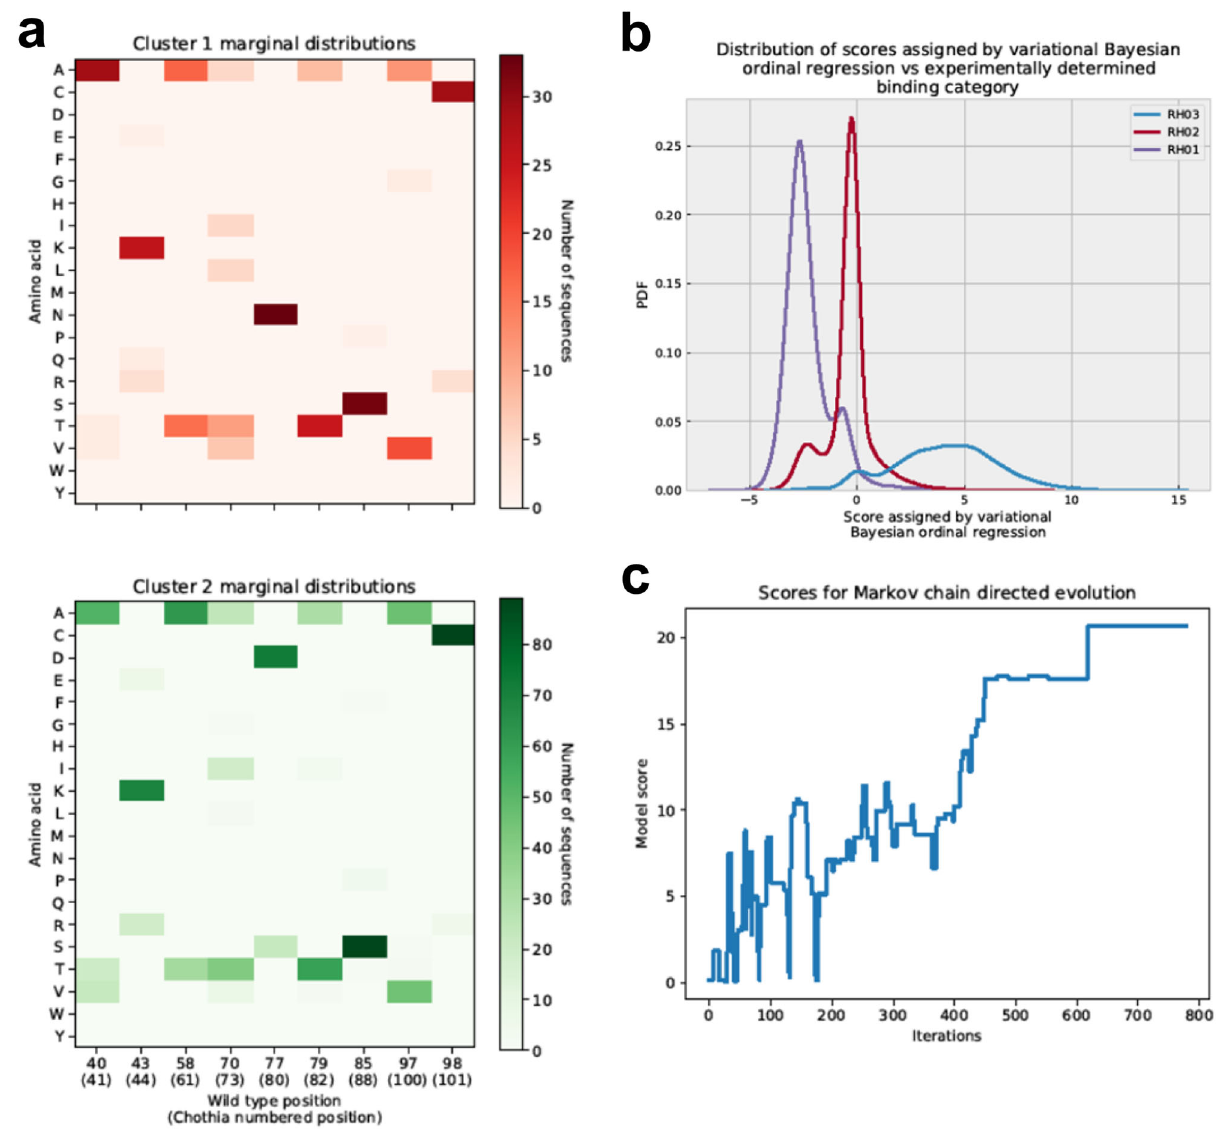
Fig. 6 | Analysis of pipeline results. a The per-position marginal distributions in the two main clusters. Each main cluster has several subclusters as apparent from the marginal distribution. Only positions mutated in either cluster are displayed. Each position is numbered fi rst using numbering from the wild-type sequenceand then in parenthesis using Chothia numbering. b illustrates the distribution of scores assigned to sequences in each binding category by the variational Bayesian model, which is designed to perform ordinal regression (classi fi cation on ranked categories). The experimental data does not directly measure off-rates but rather